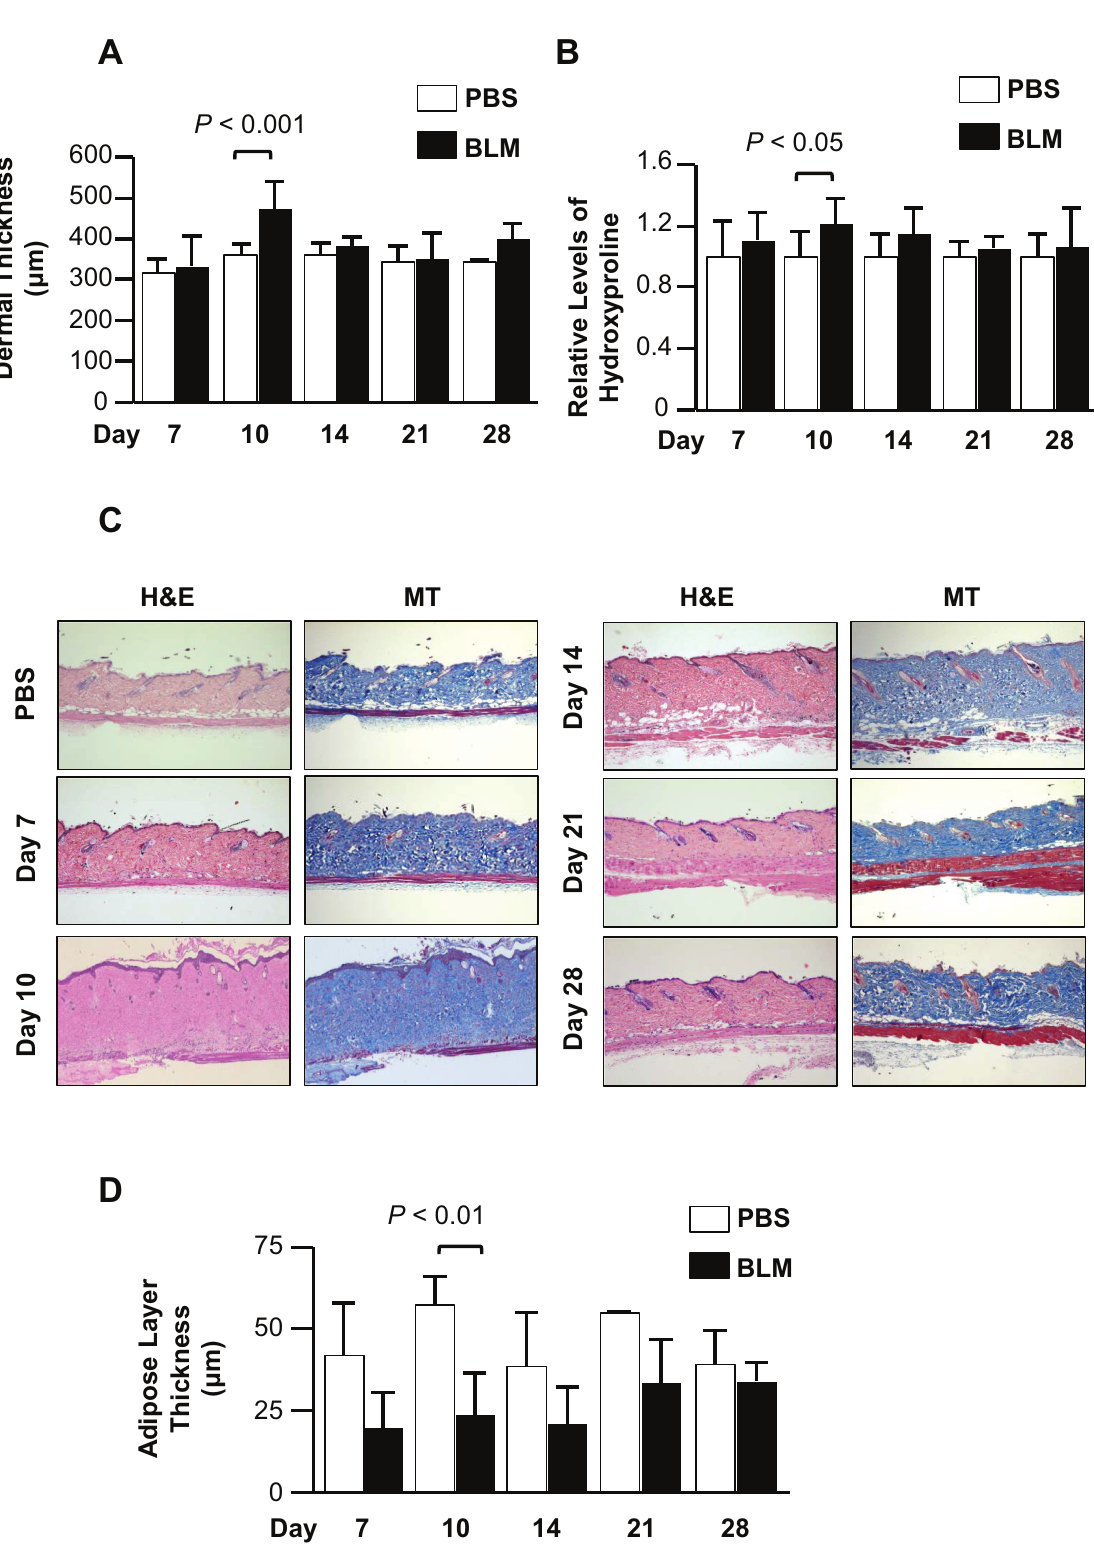
Fig 3. The effects of high dose BLM on dermal fibrosis. Mice treated with BLM (60 U/kg) were sacrificedon days 7 (N = 7), 10 (N = 12), 14 (N = 7), 21 (N = 12), and 28 (N = 6). (A) Dermal thickness was measuredin the dorsalskin. (B) Hydroxyproline